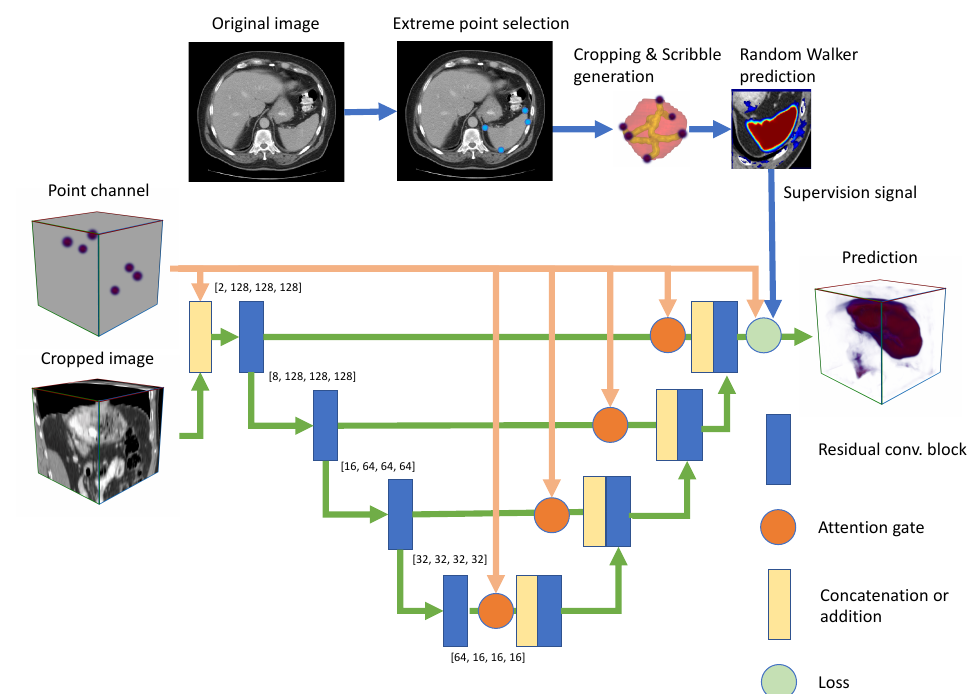
Figure 1. A high-level overview of our proposed network architecture and weakly supervised learning approach. First, the user selects six extreme points that define the 3D bounding box around the organ of interest and are used to automatically generate the scribbles that are the input (together with the image) to the random walker algorithm, whose output prediction serves as the supervision signal for training the segmentation network. The network receives both a image channel input and a point channel input that represents the user-provided extreme points. The point channel is then used throughout the network to further guide the segmentation training, i.e., as an additional input to attention gates and in the loss function. The feature shapes of each layer of the encoder are shown for the setting used in this